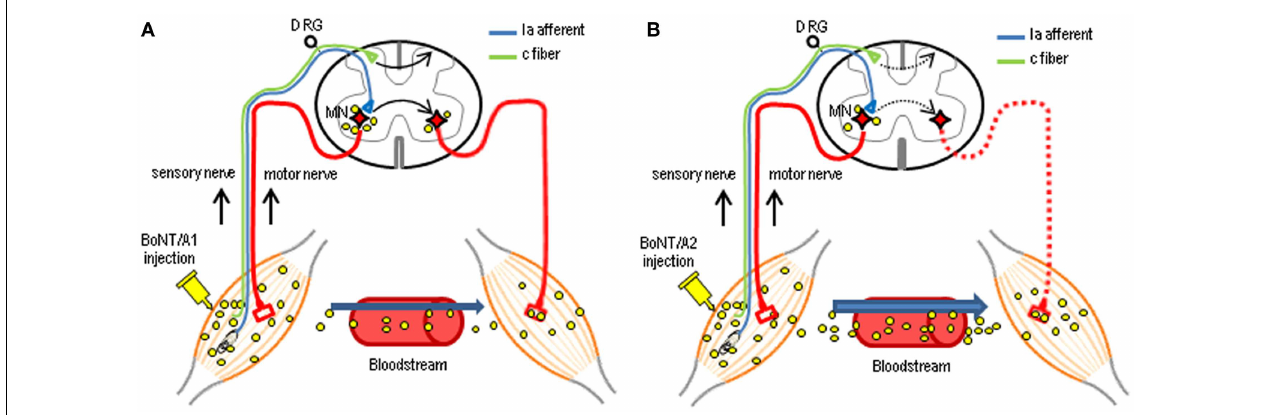
the neuron at one side, followed by its movement and release at the opposite end, with possible uptake by second-order neurons. Differential delivery routes by which injected BoNT/A1 and BoNT/A2 affect contralateral muscles have also been proposed as BoNT/A1 (A) is transported almost equally to the contralateral muscles via this neural pathways and the blood circulation, while BoNT/A2 (B) is mainly transported to contralateral muscles via the bloodstream only at higher doses. MN, motoneuron; DRG, dorsal root